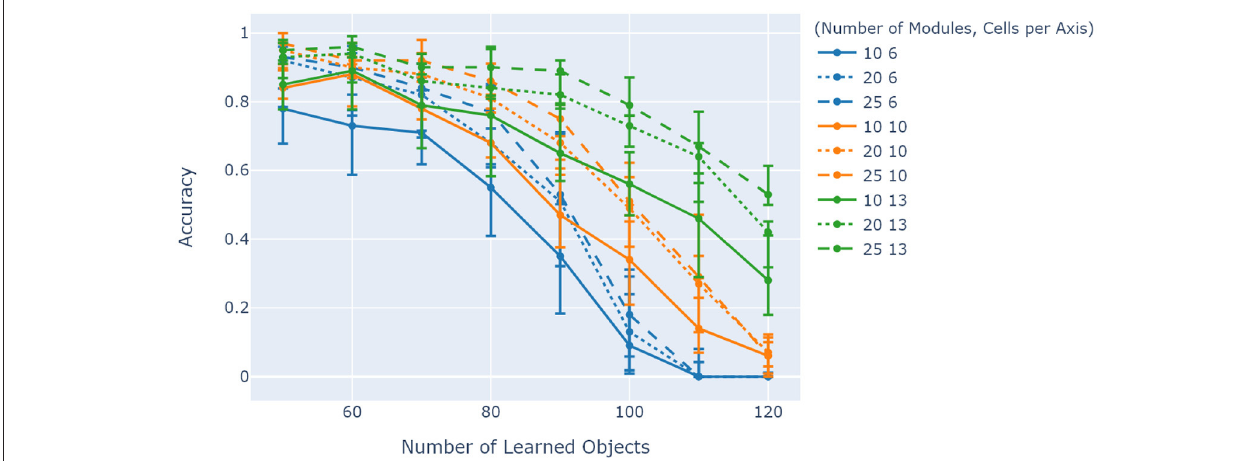
FIGURE 8 | Comparison between the effects of cells per axis and number of modules on model accuracy. Object ambiguity is adjusted by varying the amount of learned objects for a fixed number of unique features of 40. Cells per axis is denoted by color and number of modules is shown by line shape. The illustration shows that generally models with more cells per module have better accuracy for more ambiguous objects, but only if they have enough grid cell modules to counteract the increased projection errors from higher cells per module. The experiment was repeated 10 times, with the 5th, 50th, and 95th percentiles